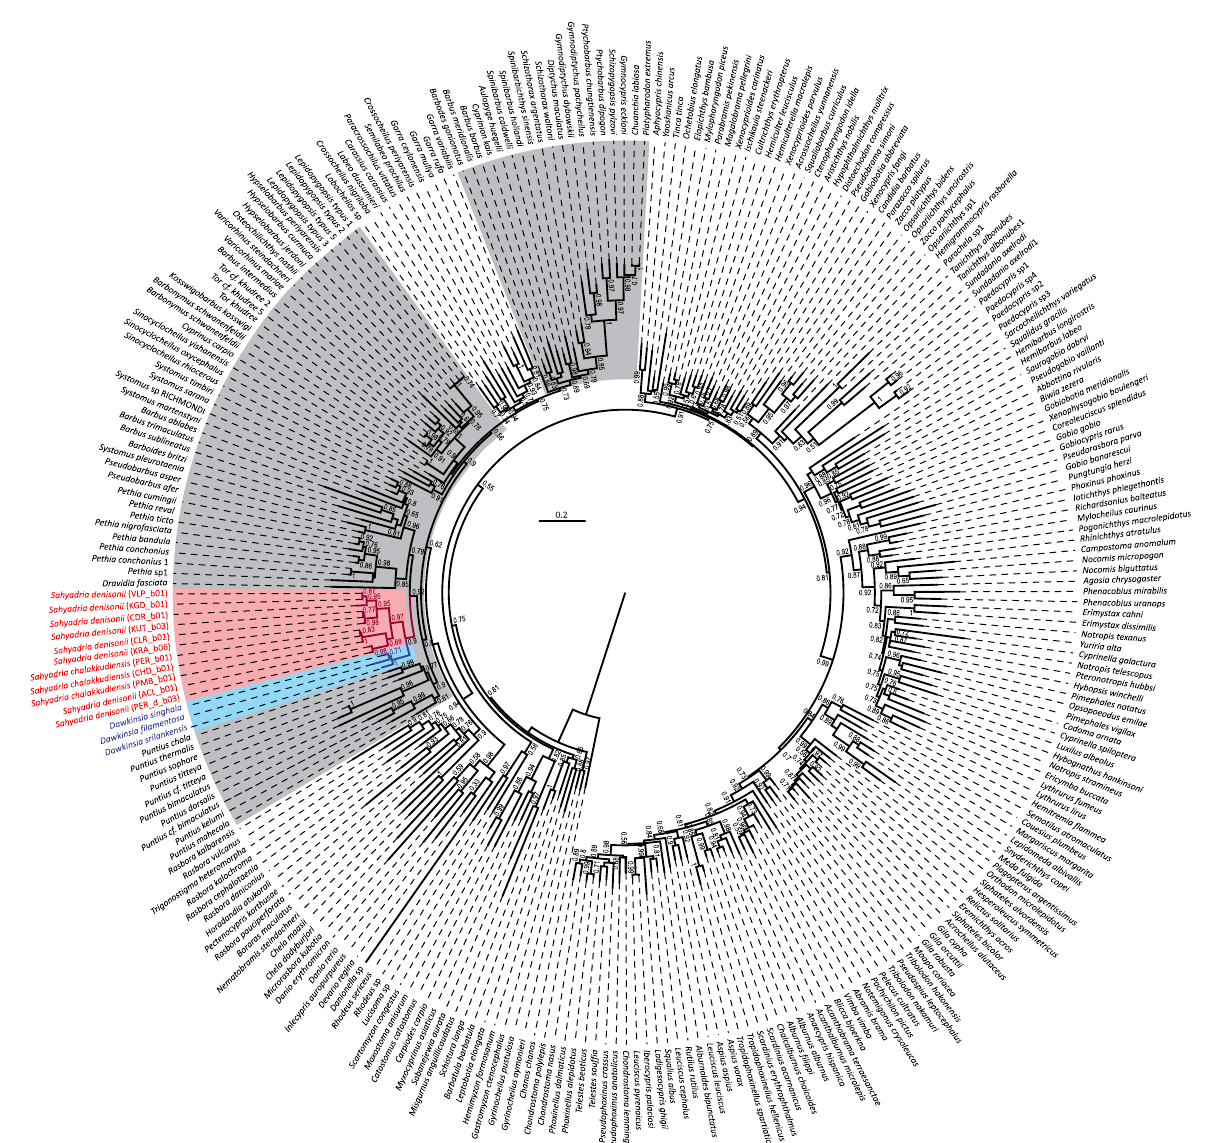
Figure 3. Exact phylogenetic position of Sahyadria . Genera currently considered in subfamily Barbinae are highlighted in grey and the clades of interest Sahyadria and Dawkinsia are highlighted in red and blue